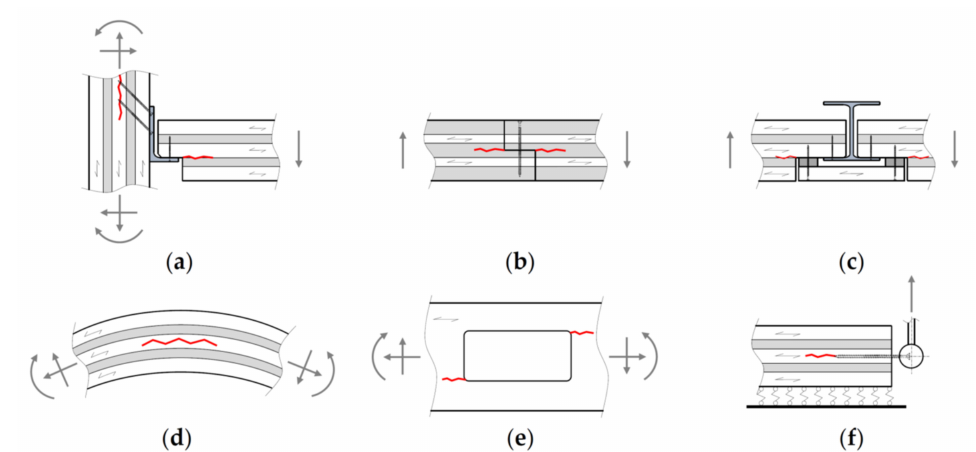
Figure 1. Examples for tensile stresses out-of-plane in CLT elements and connection details: ( a ) notched CLT floor element and screwed joint to CLT wall; ( b ) half-lapped joint between CLT floor elements; ( c ) notched CLT floor elements resting on I-beam in steel covered by fire protection layer; ( d ) curved CLT element; ( e ) opening in CLT beam; ( f ) CLT element lifted for